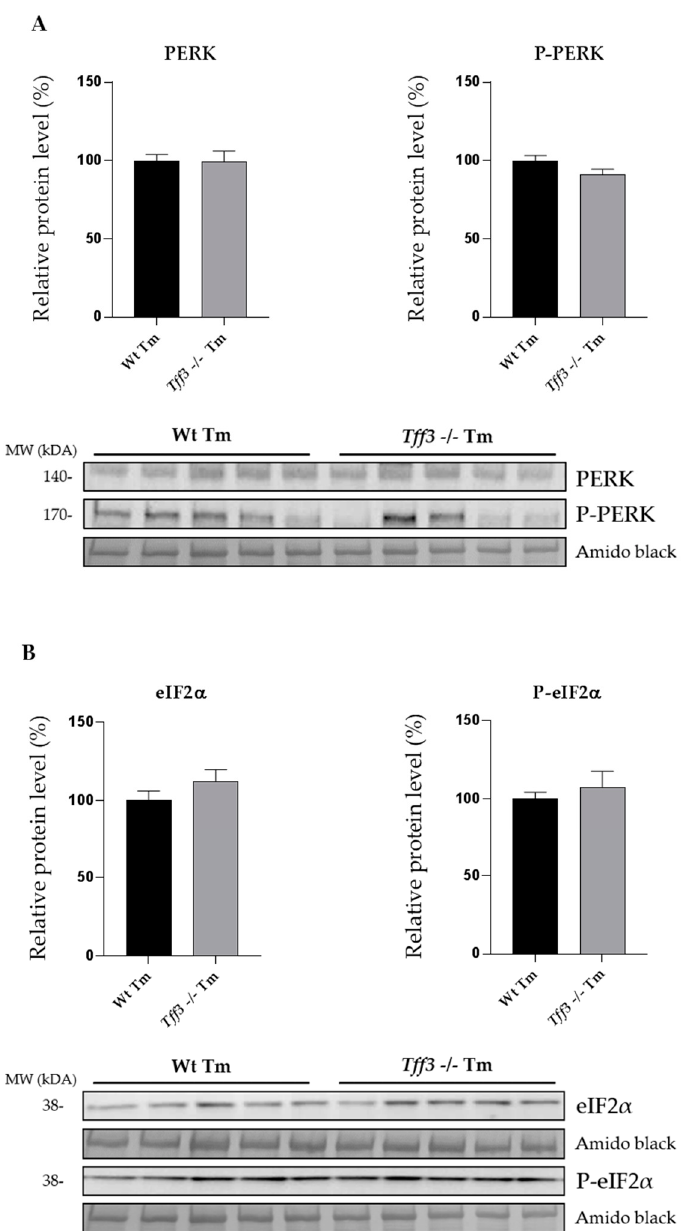
Figure 2. Effect of ER stress on PERK ( A ) and eIF2 α ( B ) protein phosphorylation. Relative protein levels of ER stress markers, (PKR)-like endoplasmic reticulum kinase (PERK), p-PERK ( A ) and eIF2 α and p-eIF2 α ( B ) in liver homogenate of wild type mice and Tff3 − / − mice treated with tunicamycin. Protein level is presented relative to Wt mice as mean ± SEM of specific protein band density normalized with amido black. The difference between the groups was compared by the Student t - test. Wt Tm = wild type tunicamycin-treated mice, Tff3 − / − Tm = Tff3 − / − tunicamycin-treated mice.